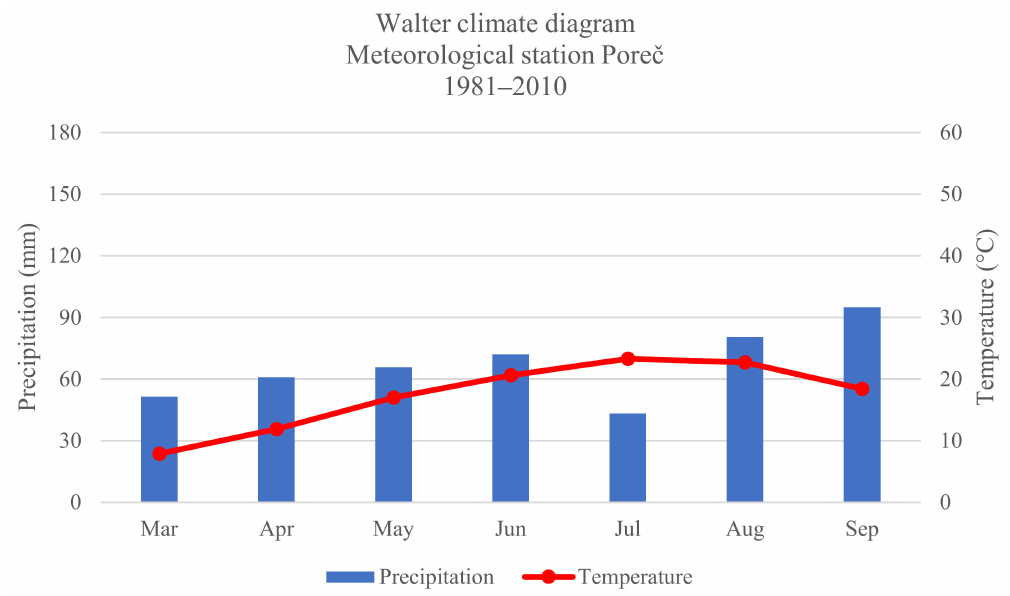
Figure 1. Walter climate diagram for meteorological station Poreˇc, multiyear average (1981–2010).